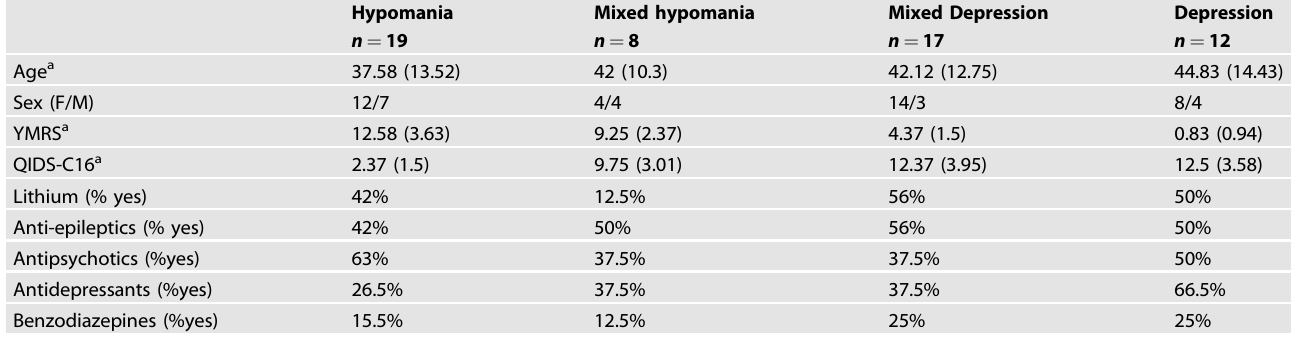
Table 1. Demographic characteristics of the patient